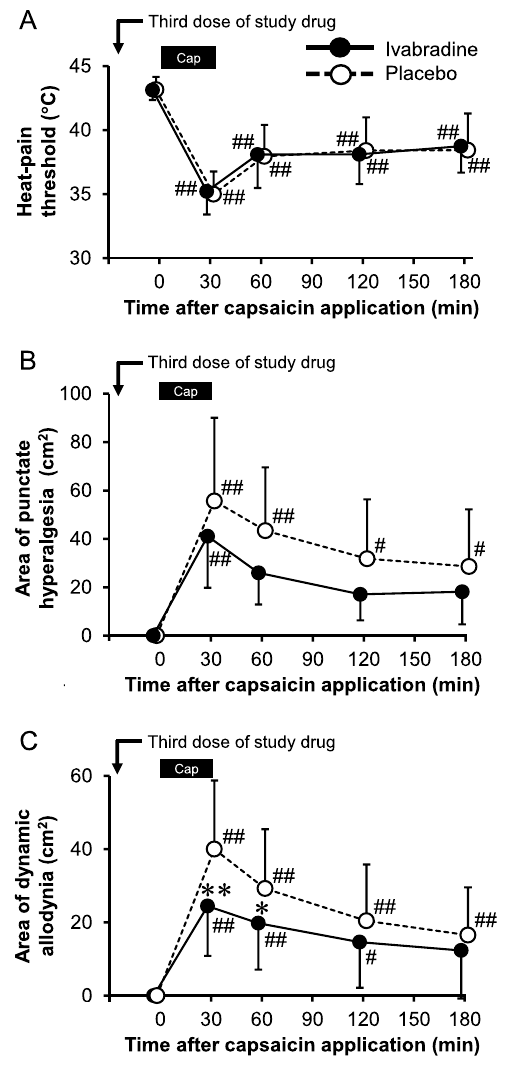
Figure 4. Effects of ivabradine and placebo on capsaicin-induced changes in heat sensitivity, and areas of punctate mechanical hyperalgesia and dynamic mechanical allodynia. Heat-pain threshold temperature was measured at the primary zone before and after capsaicin application and is presented in the panel (n = 20 in each group) ( A ). The area of punctate mechanical hyperalgesia was mapped using a von Frey filament of 15 g (n = 10 in each group) ( B ). The area of dynamic mechanical allodynia was mapped using a foam brush (n = 20 in each group) ( C ). Data are expressed as means ± standard deviation. Asterisks indicate statistically significant differences between the groups (* p < 0.05 and ** p < 0.01). Statistical significance from baseline was indicated as # p < 0.05 and ## p < 0.01. Statistical analysis was performed using two-way ANOVA with Scheffe’s multiple comparisons post-hoc test. The bar labeled as “Cap” at the top of the panel depicts the onset and duration of capsaicin